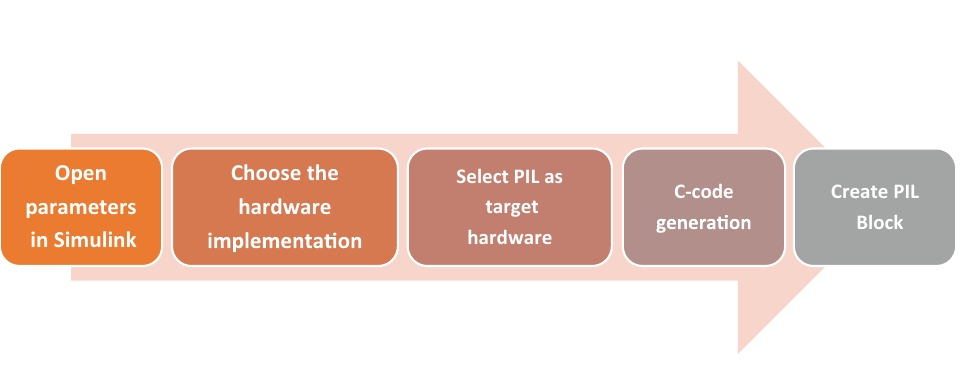
Figure 10. Steps to parameterize PIL test using STM32F407